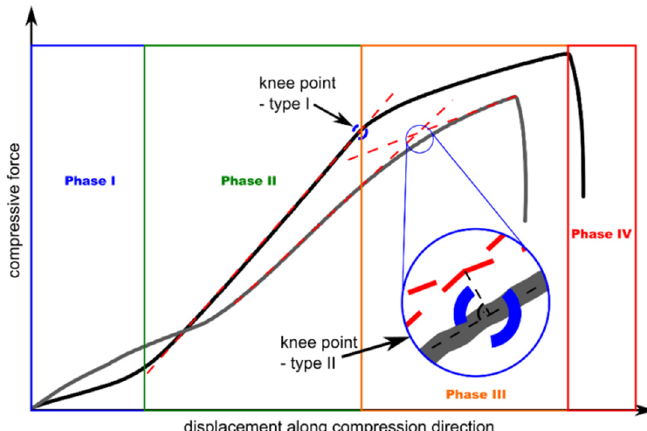
Figure 6. Phases of the FMLs’ mechanical response while subjected to CAI and methods of knee-point estimations. Phase I—system stabilization, Phase II—linear force growth, Phase III—gradual stiffness degradation, Phase IV—critical failure.